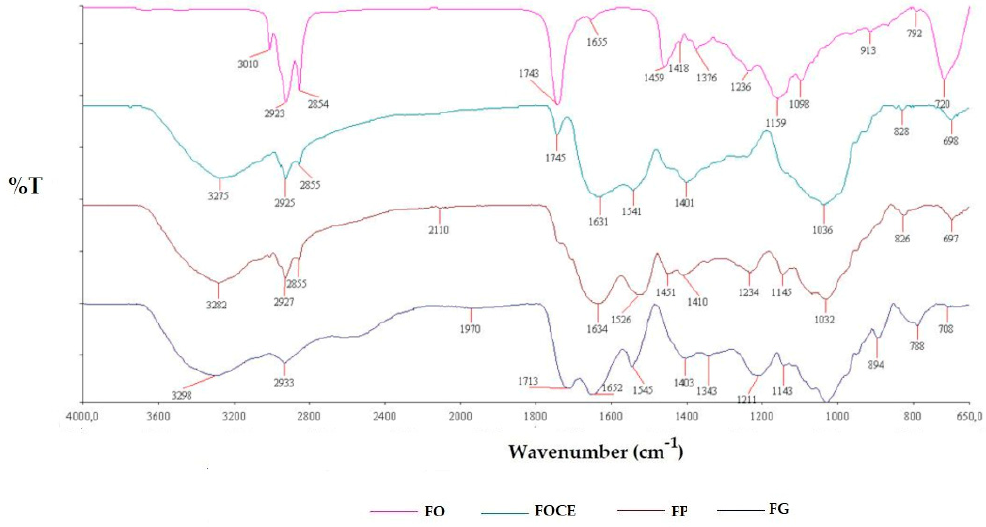
Figure 1. The FTIR spectra of flaxseed oil (FO), flaxseed oil cake extract (FOCE), flaxseed protein (FP), and flaxseed gum (FG).